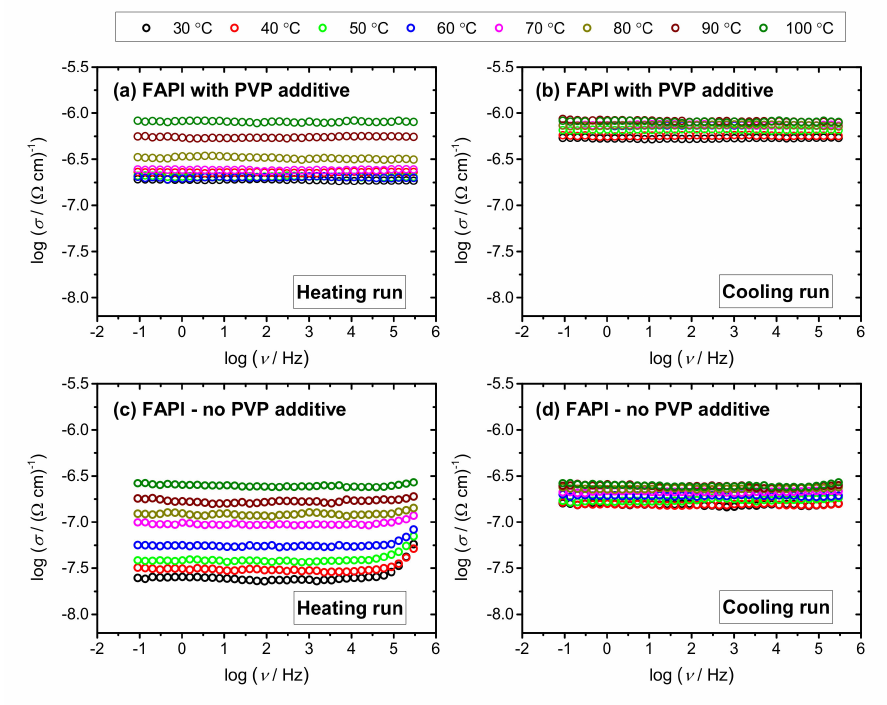
Figure 11. Conductivity spectra for FAPI perovskite thin films on ZNR/glass substrate with ( a , b ) and without ( c , d ) PVP additive in heating ( a , c ) and cooling ( b , d )